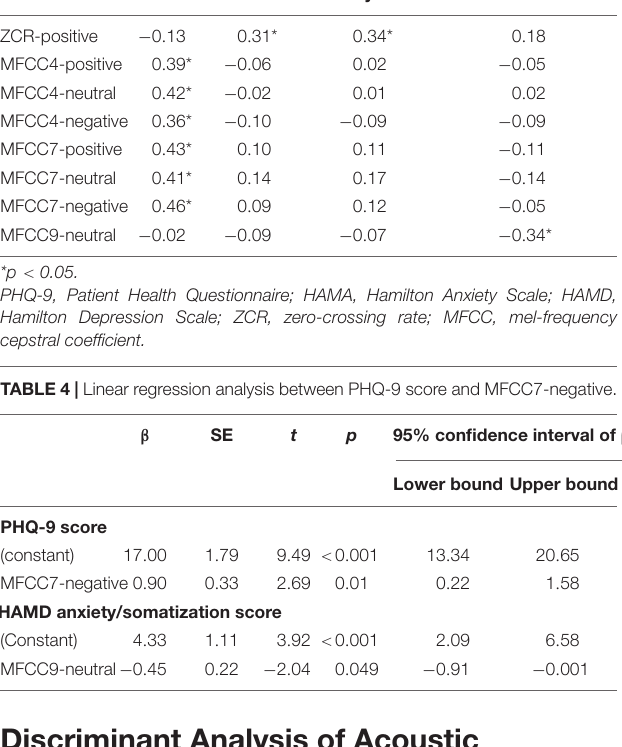
TABLE 3 | The correlation between depressive symptom severity and acoustic TABLE 5 | The discriminant result of grouping by different characteristics. PHQ-9 HAMA HAMA somatic HAMD anxiety/ score total score anxiety score somatization score